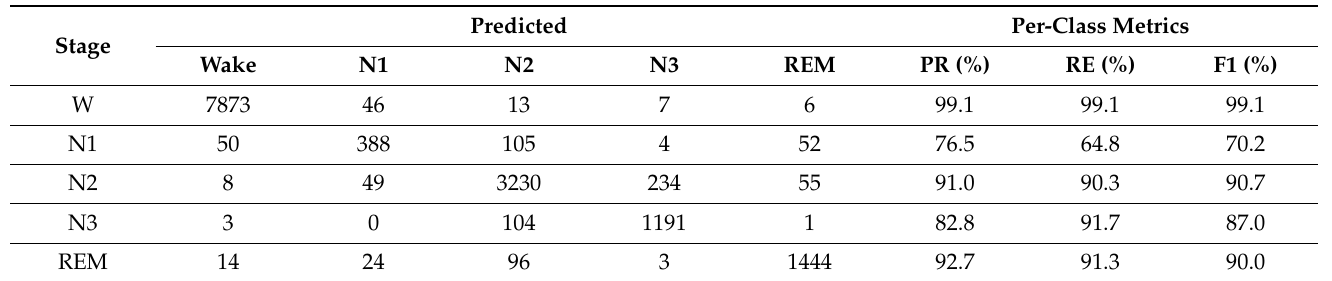
Table 3. Confusion matrix of Sleep-EDFX-8 dataset.